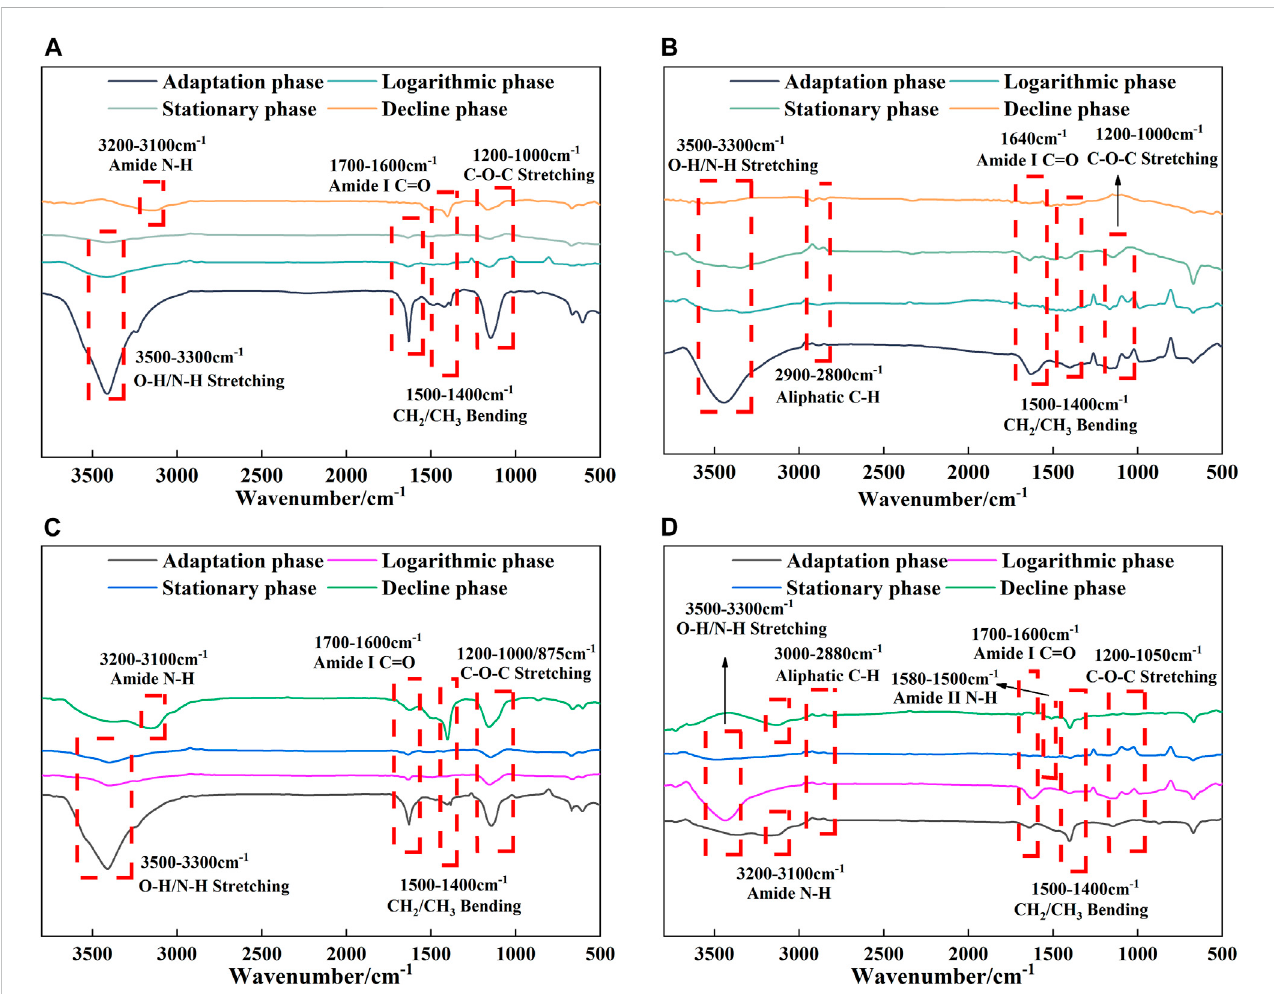
FIGURE 3 FT-IR spectra of Chlorella vulgaris and Scenedesmus obliquus at different growth stages. (A) Chlorella vulgaris EOM; (B) Chlorella vulgaris IOM; (C) Scenedesmus obliquus EOM; (D) Scenedesmus obliquus IOM.